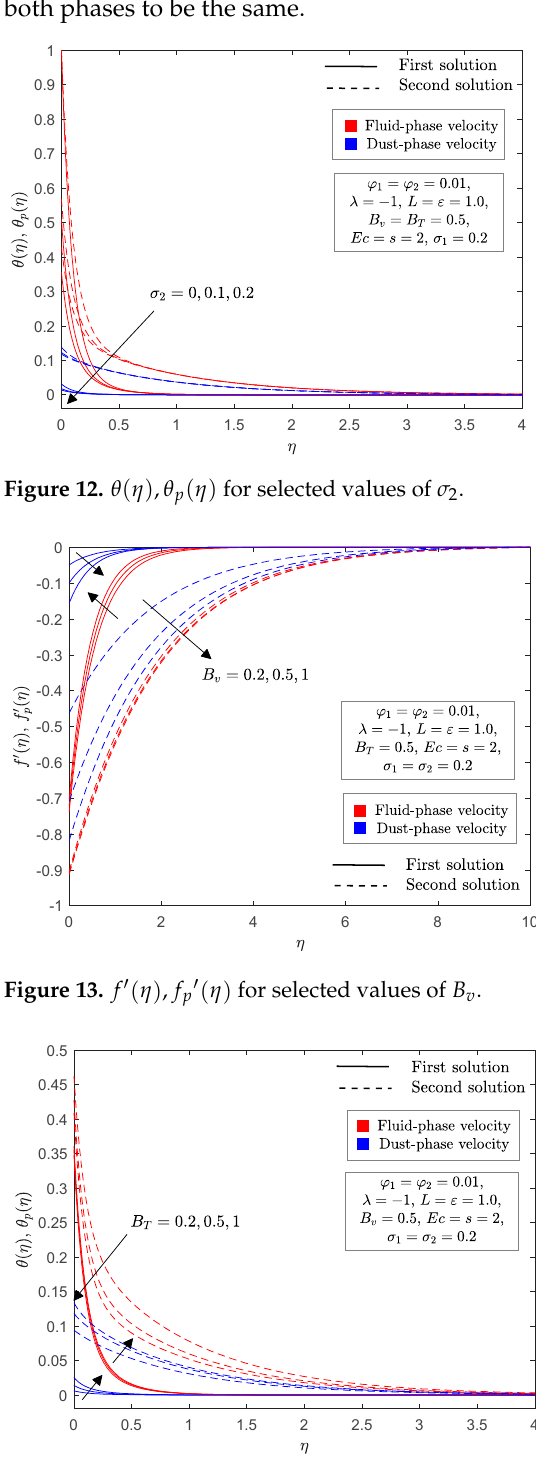
B Figure 14. θ ( η ) , θ T B T